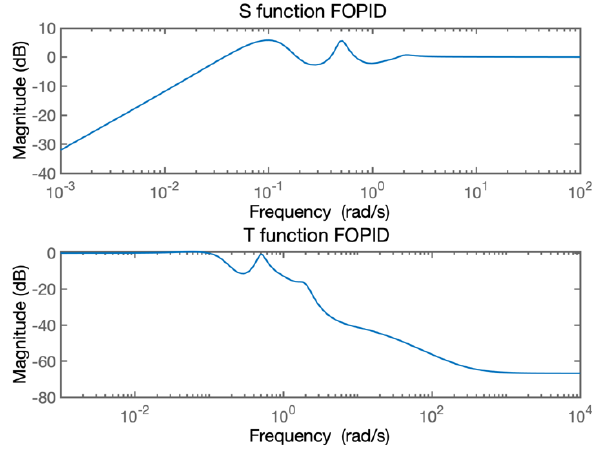
Figure 9. FOPID sensitivity measures.